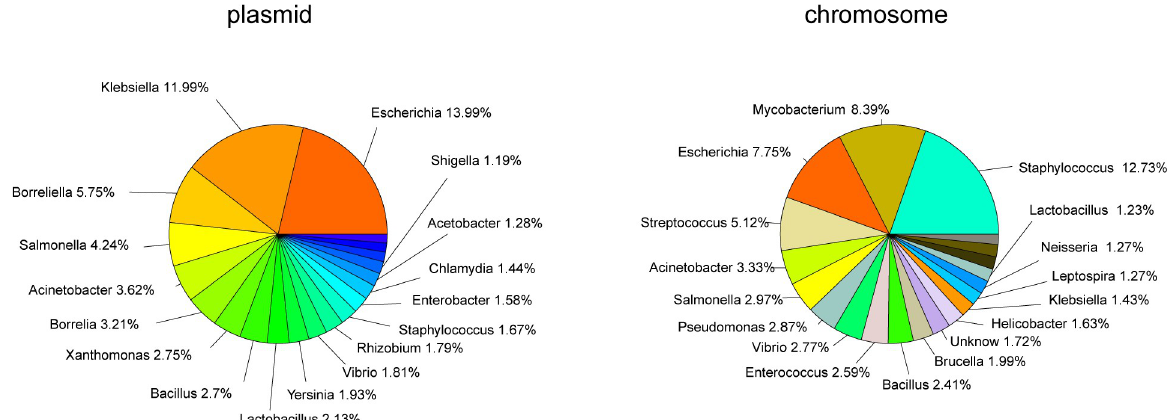
Fig 1. Top 20 genera in the plasmid and chromosomal datasets. A total of 10,654 chromosomal contigs and 10,584 plasmid contigs were used. Genera representing greater than 1% of the contigs are labeled.